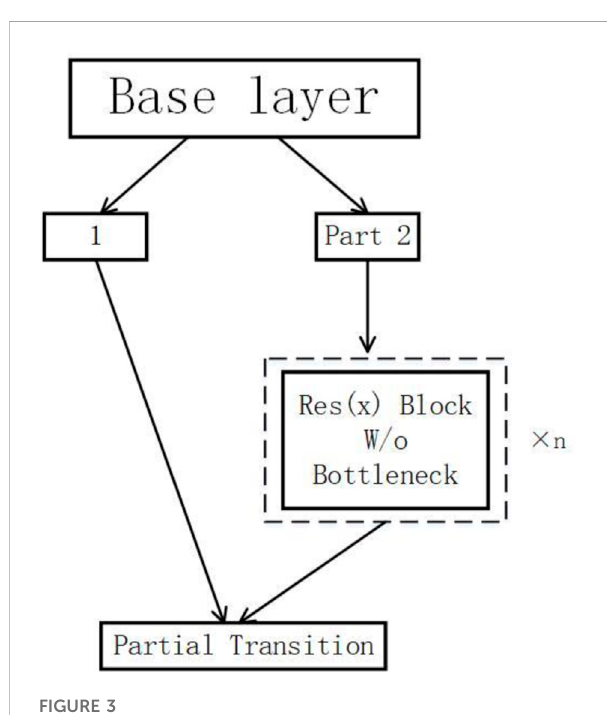
FIGURE 3 CSPnet network